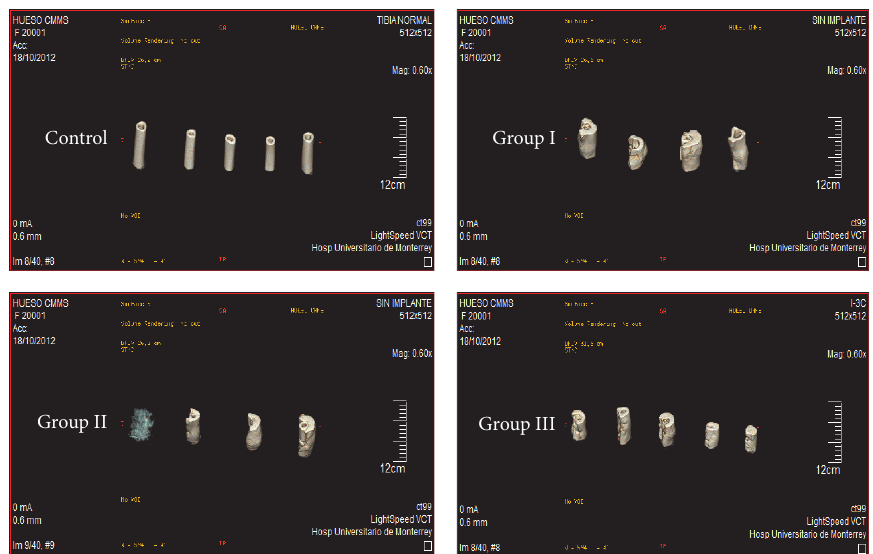
Figure 8: 3D computerized tomography of the area of a lesion in each sheep by group 10 weeks after surgery (postmortem).